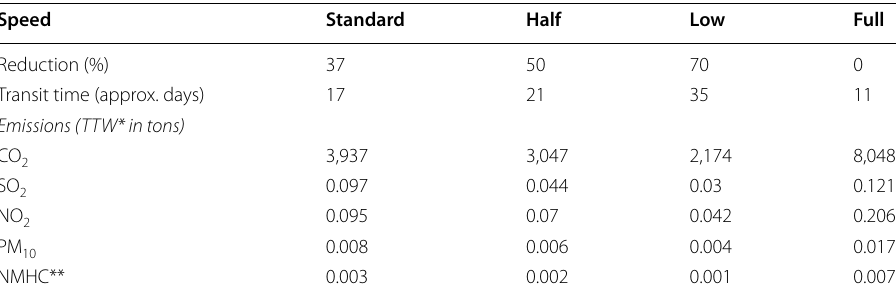
Table 6 Dependence of emissions on the speed mode of the containership on the Shanghai—Los Angeles route. Source : EcoTransIT World (2022)